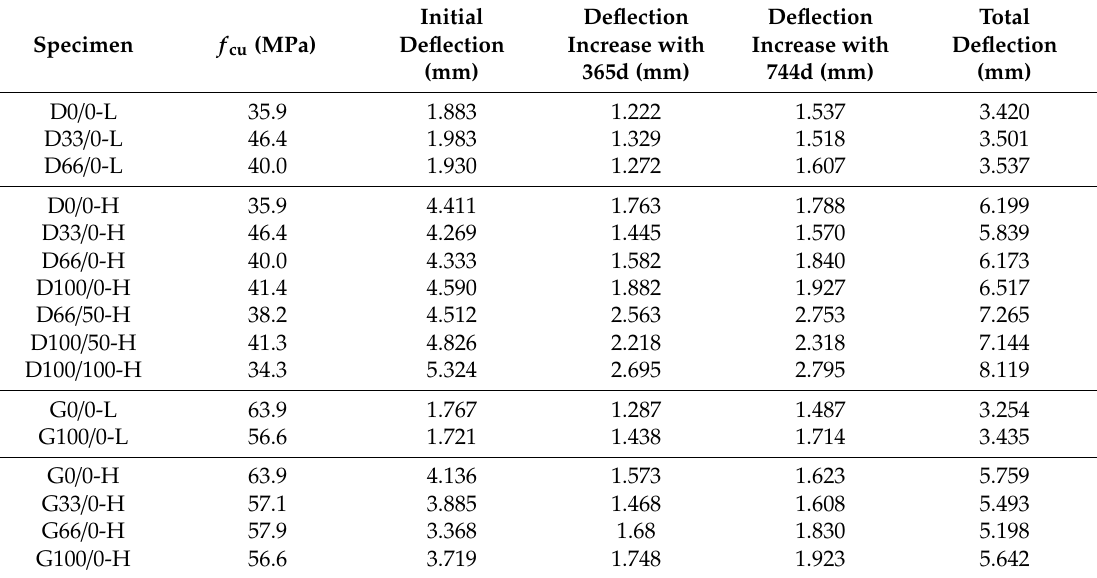
Table 5. Tested deflection values of the specimens